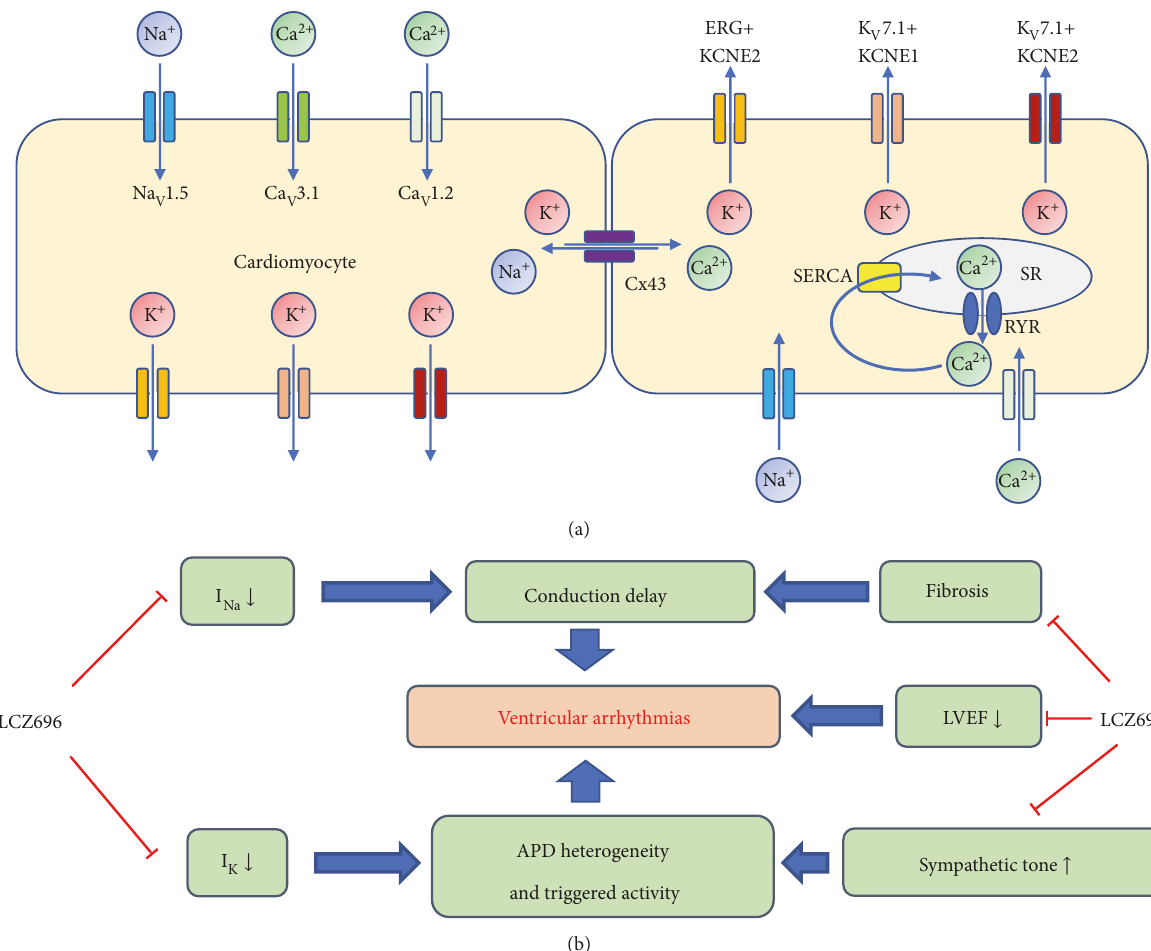
Figure 5: (a) Action potential generation associated ion channel proteins test in this study. (b) Summarized diagram of the effects of LCZ696 therapy on the HF-MI rat model. APD, action potential duration; I reticulum Ca -ATPase; SR, sarcoplasmic reticulum; RYR, ryanodine 2+